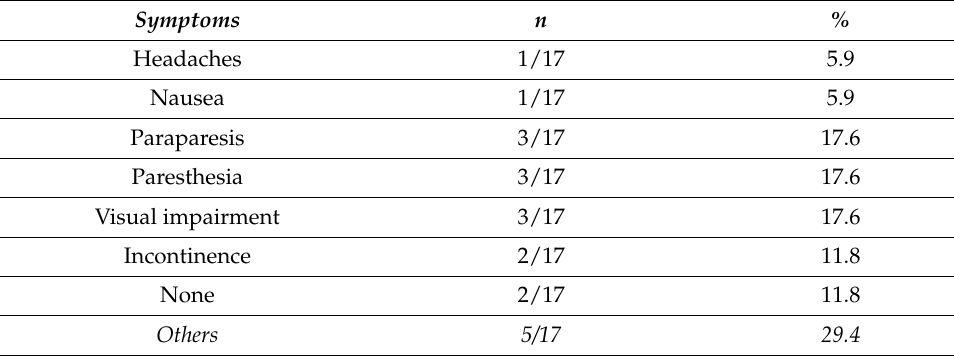
Table 2. Symptoms related to leptomeningeal carcinomatosis.